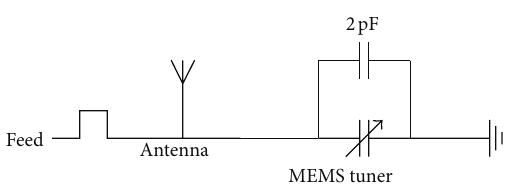
Figure 10: Schematic of the miniaturization demonstrator.